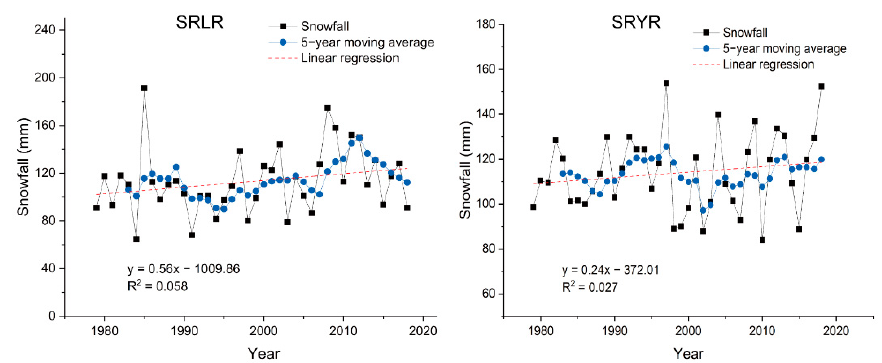
Figure 3. Snowfall anomaly and 5-year moving average for the study area.